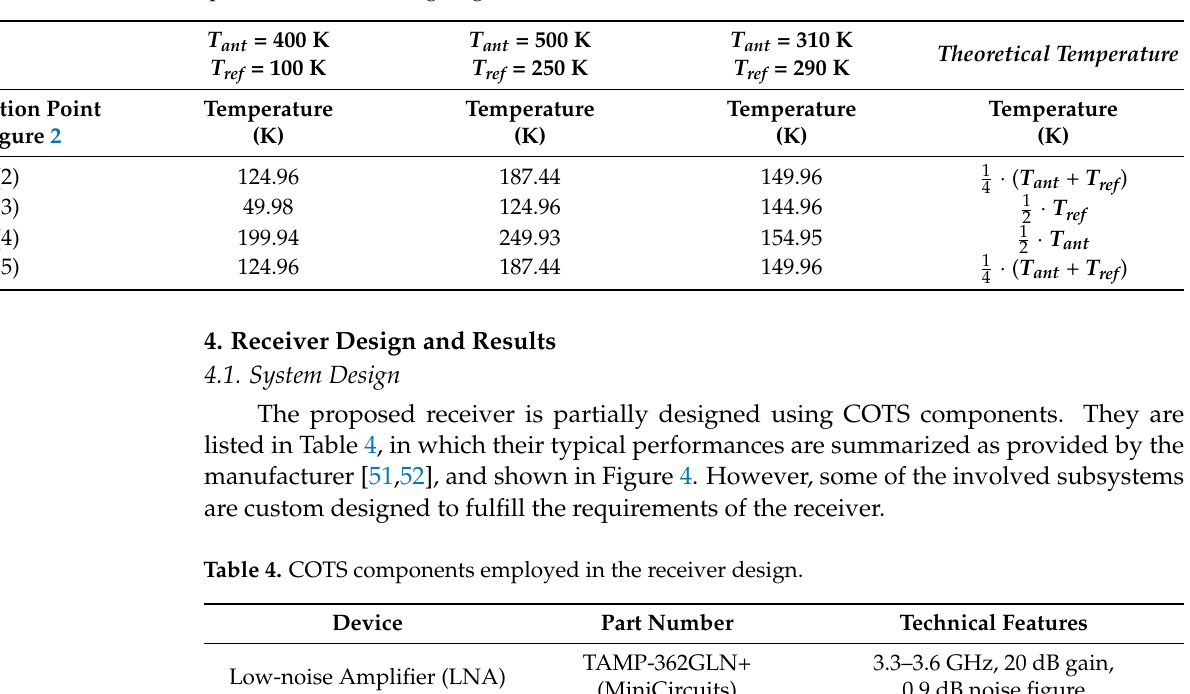
Table 3. Simulated temperatures at 3.5 GHz at each predetection point for different input signals for a noiseless receiver ( T rec3 = 0 K) and without amplification and filtering stages.